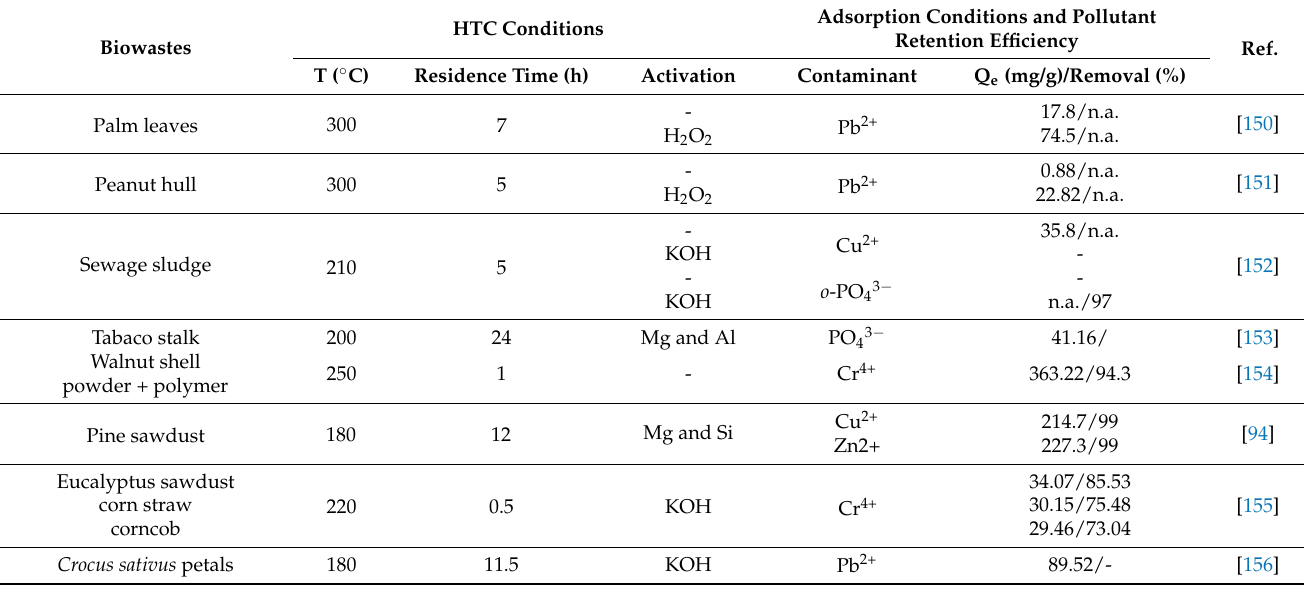
Table 3. HTC conditions and adsorption performance of HC for heavy metal removal from